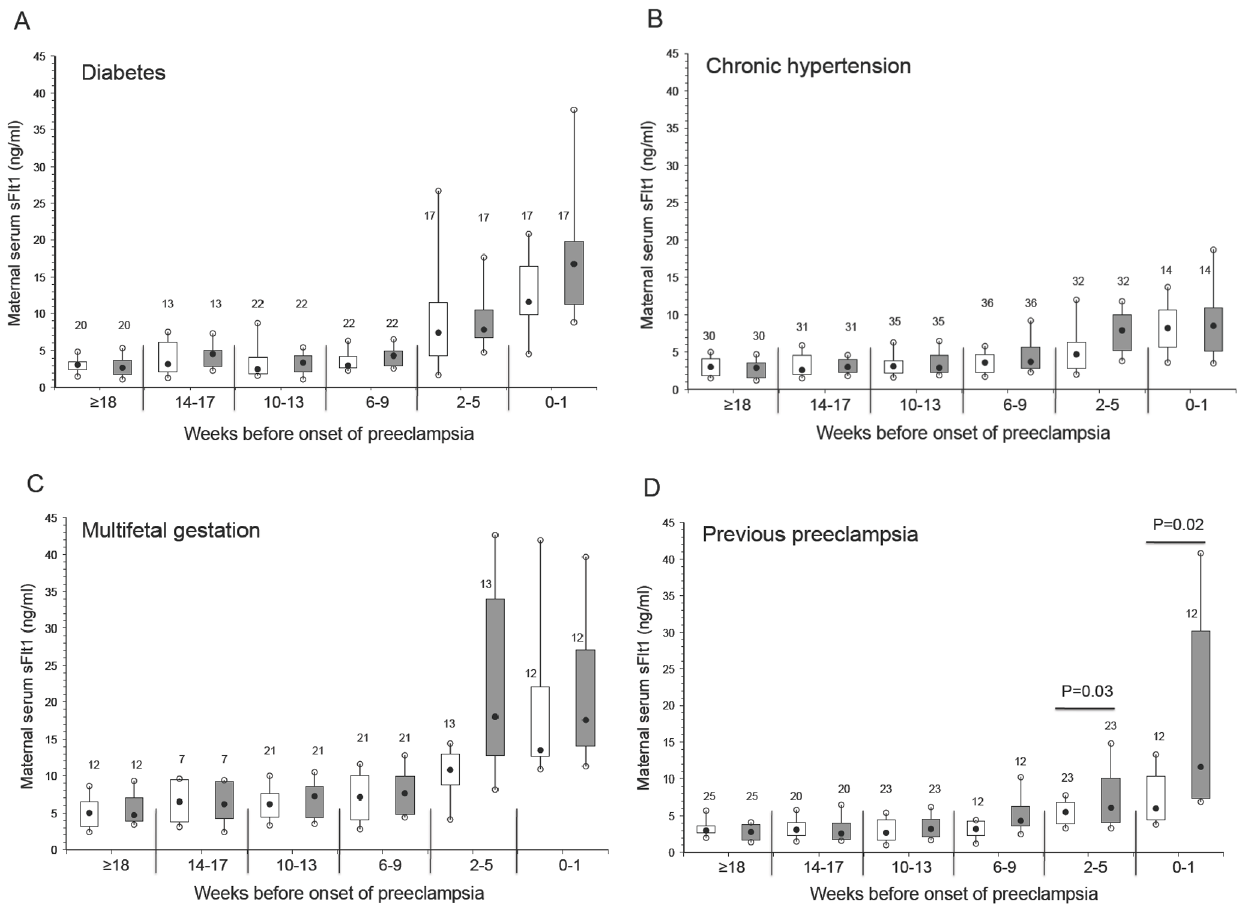
Figure 4. Maternal serum sFlt1 by clinical onset of preeclampsia matched to control samples in women with pre-existing diabetes (A), chronic hypertension (B), multifetal gestation (C), and previous preeclampsia (D). Open boxes are controls and shaded boxes are subjects who developed preeclampsia. The number above each box indicates the number of samples. The filled black circles are the median, the open circles are the 90th and 10th percentiles, and the top and bottom lines of the box are the 75 th and 25 th percentiles of the data for each group. Statistical significance is indicated by p values.